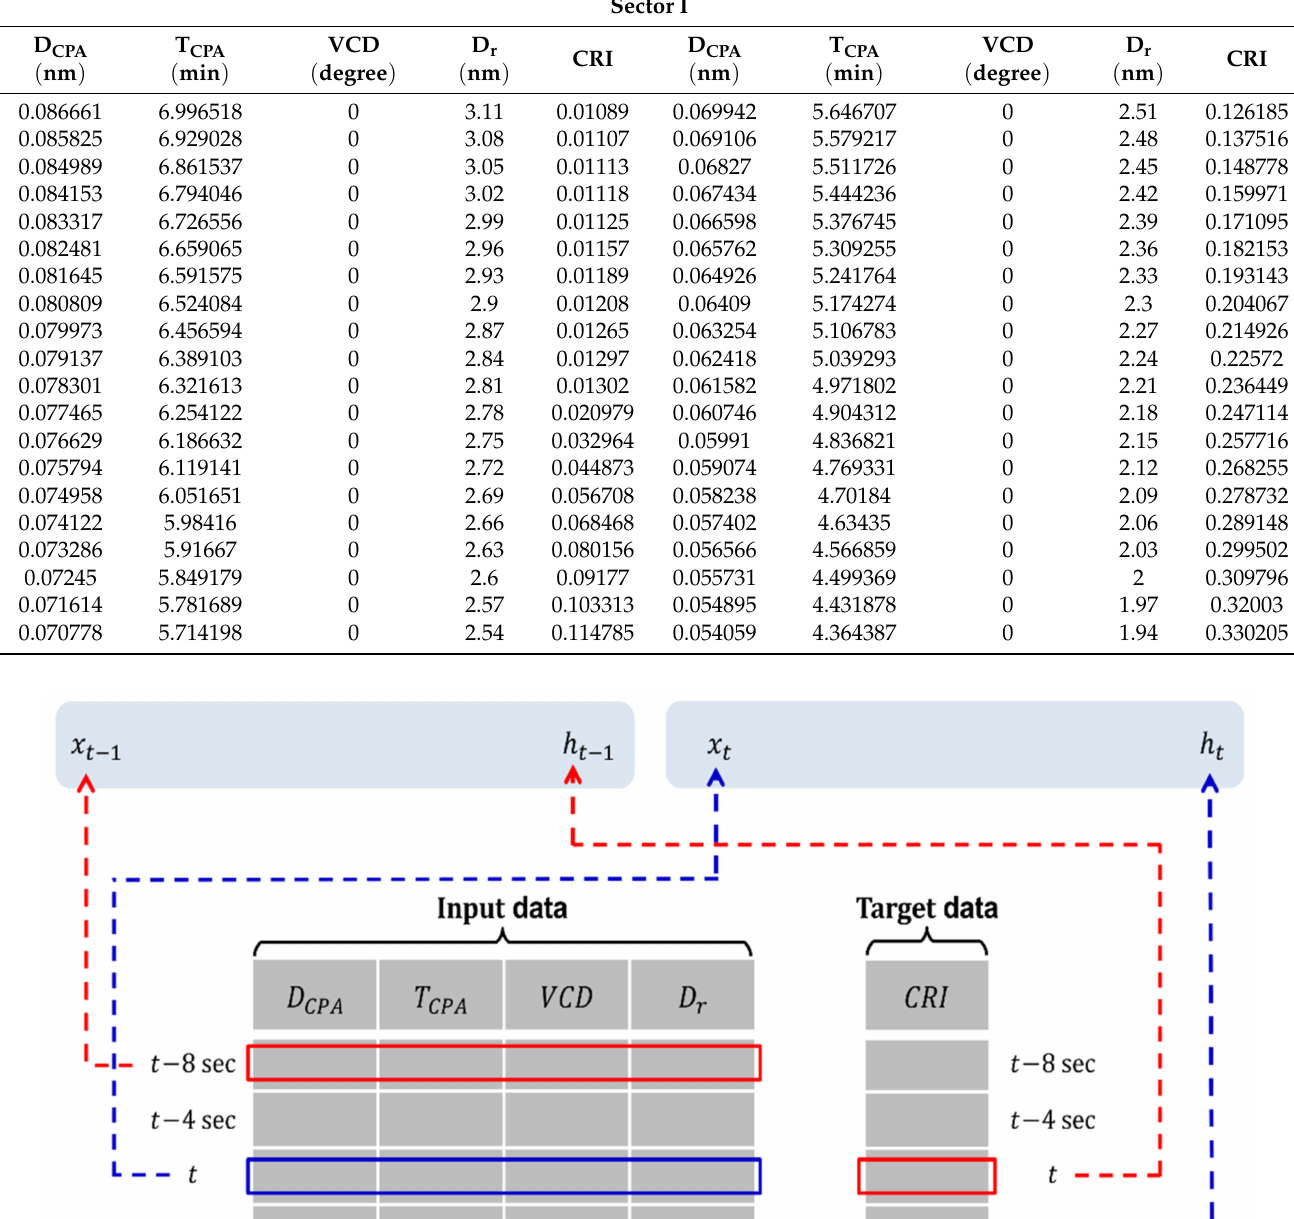
Table 3. Collected data in sector I.